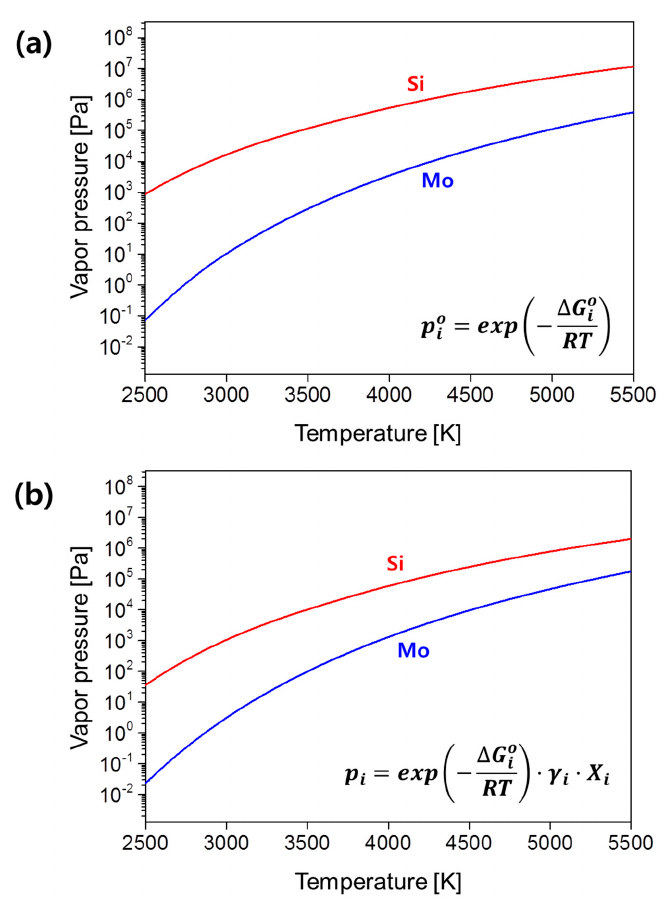
Figure 4. ( a ) Vapor pressure of pure Mo and Si with respect to temperature. ( b ) Vapor pressure of Mo and Si in molten Mo 5 Si 3 .